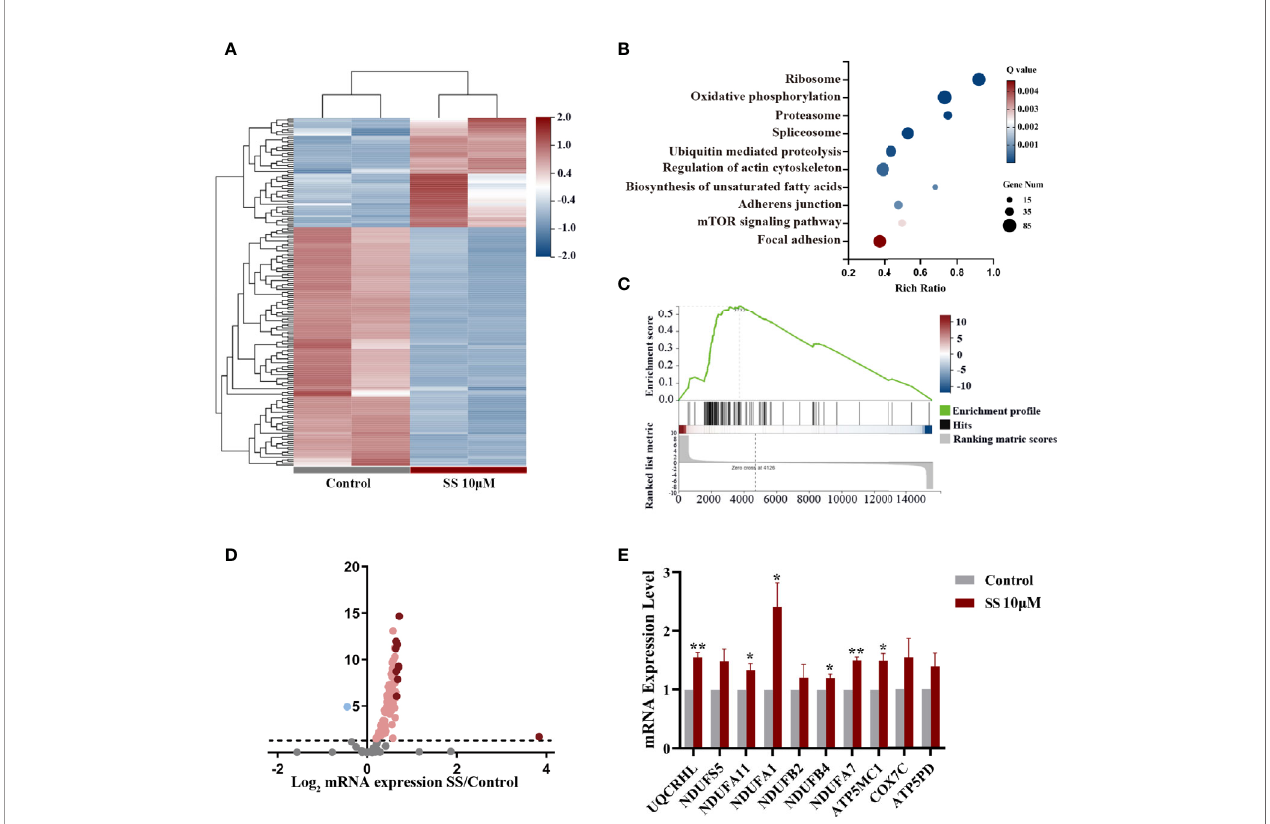
FIGURE 3 | Gene expression analysis in thyroid cancer cells treated with SS. (A) Heatmap of differentially expressed genes between the SS and control groups. (B) Pathway enrichment analysis showing the top 10 changed pathways after SS treatment. (C) Single-sample gene set enrichment analysis (ssGSEA) was used to obtain the enrichment score of the oxidative phosphorylation pathway. (D) Volcano plot of genes enriched in the oxidative phosphorylation pathway (OXPHOS). (E) Relative RNA expression of the top 10 genes enriched in OXPHOS was validated by qRT-PCR in KHM-5M cells. SS, sodium selenite. *P < 0.05; **P < 0.01.